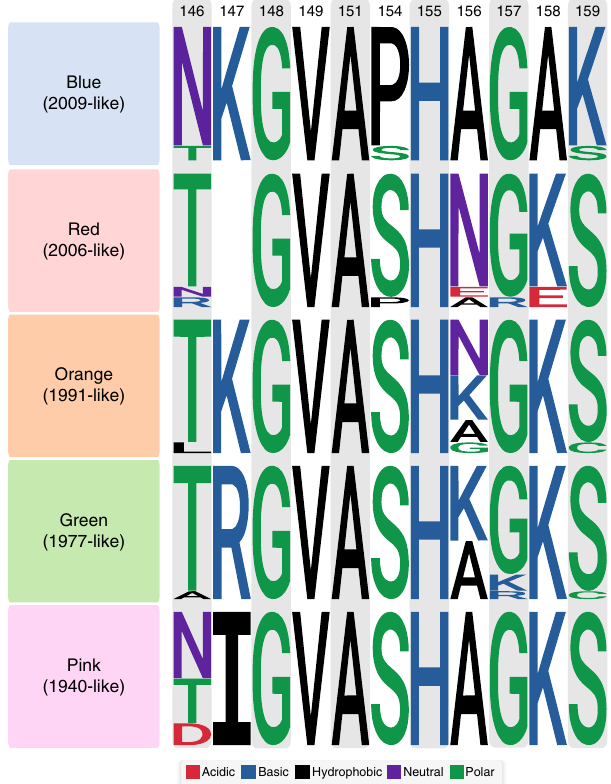
Fig. 3 Allelic classes of the OREO epitope. Sequence Logo diagrams showing the relative frequency of different amino acids for each OREO conformation based on yearly consensus sequences. The various epitopes can be de fi ned by the amino acids at positions 147, 158 and 159. These three positions have been used to de fi ne the conformations of OREO in the phylogenetic tree in Fig.